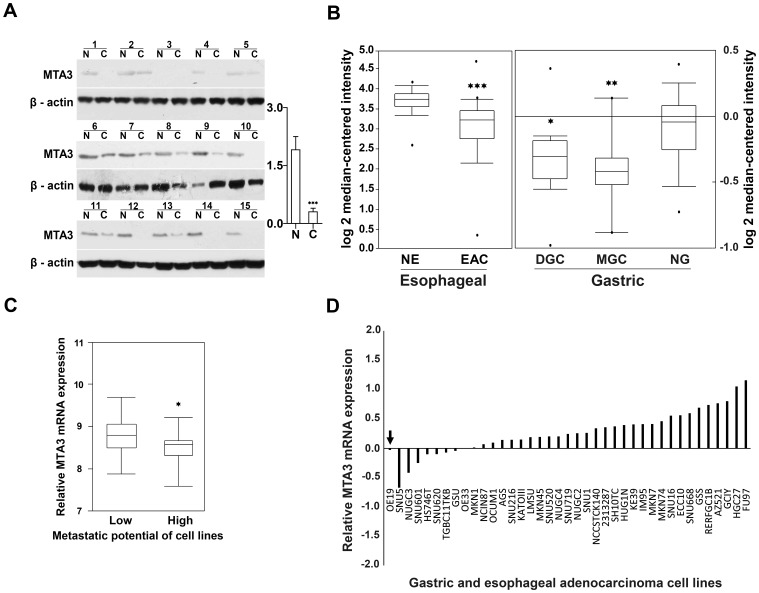
MTA3 is down-regulated in GEJ adenocarcinoma tissue and in high metastatic potential cancer cell lines.(A) MTA3 protein is down-regulated in human GEJ adenocarcinoma tissues as determined by immunoblot analysis. N, adjacent noncancerous tissues; C, cancerous tissues. (B) MTA3 transcript is significantly decreased in esophageal and gastric adenocarcinoma tissues, relative to the corresponding normal tissue. The data were from the analysis in Oncomine database. NE, normal esophagus (n = 28); EAC, esophageal adenocarcinoma (n = 75); NG, normal gastric (n = 29); GC, gastric cancer (n = 20). (C) MTA3 mRNA level is decreased in high metastatic potential cell lines of gastric adenocarcinoma and esophageal adenocarcinoma. Gene expression data for MTA3 were extracted from “CCLE Expression Entrez 2012-04-06”. (D) In all 39 tumor cell lines, the exclusively available GEJ adenocarcinoma cell line OE-19 (arrow), which has high metastatic potential, fell into the decreased-MTA3 group composed of 9 cell lines, 7 of which are more invasive. *P<0.05, **P<0.01, ***P<0.001.